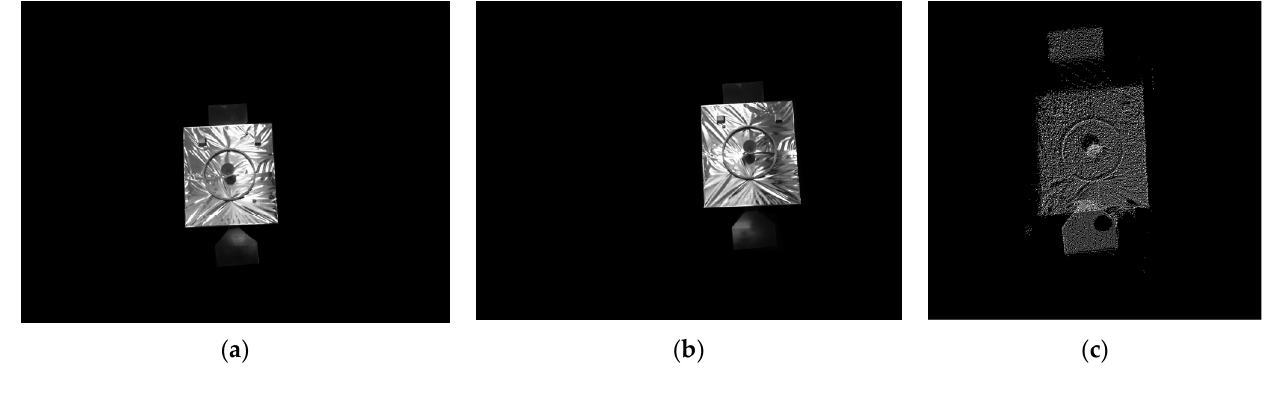
Figure 14. Left and right camera images and TOF camera data: ( a ) left image; ( b ) right image; ( c ) point cloud.